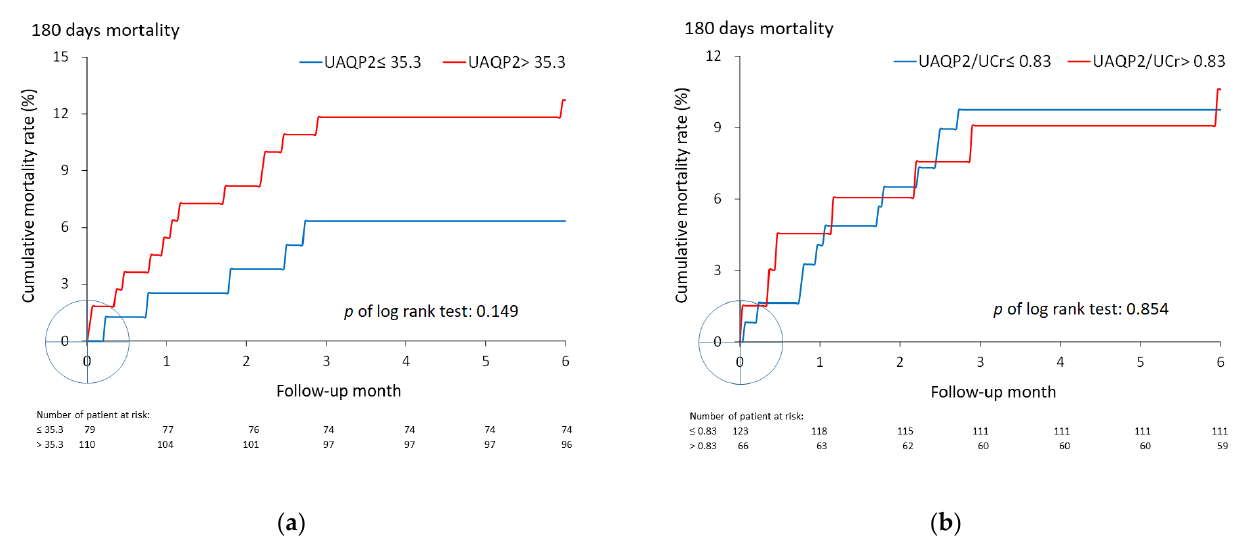
Figure 3. Cumulative mortality rates during 180-day follow-up of patients, with stratification of the optimal cutoff of UAQP2 ( a ) and UAQP2/UCr ( b ). Abbreviations: UAQP2, urinary excretion of aquaporin 2; UCr, urine creatinine.